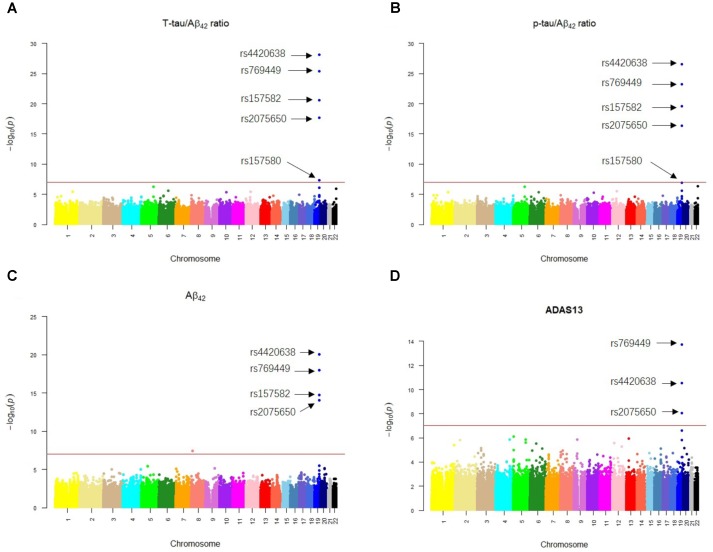
The Manhattan plots of the observed –log10 (p-value) for the results of QTL analysis for (A) T-tau/Aβ42 ratio, (B) p-tau/Aβ42 ratio, (C) Aβ42 concentration, and (D) ADAS13 scores. SNPs with FDR < 0.05 were labeled on each plot. Redline stood for p-value = 10-7.